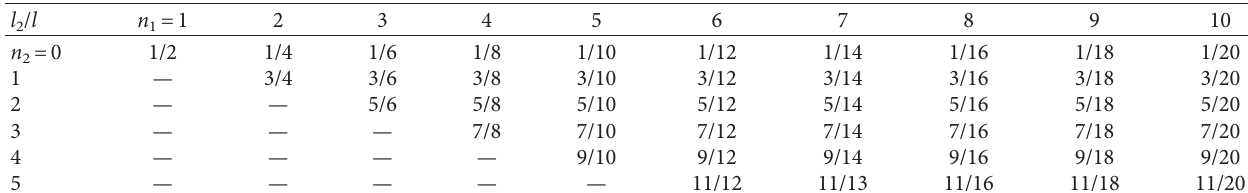
Table 2: The location of the side